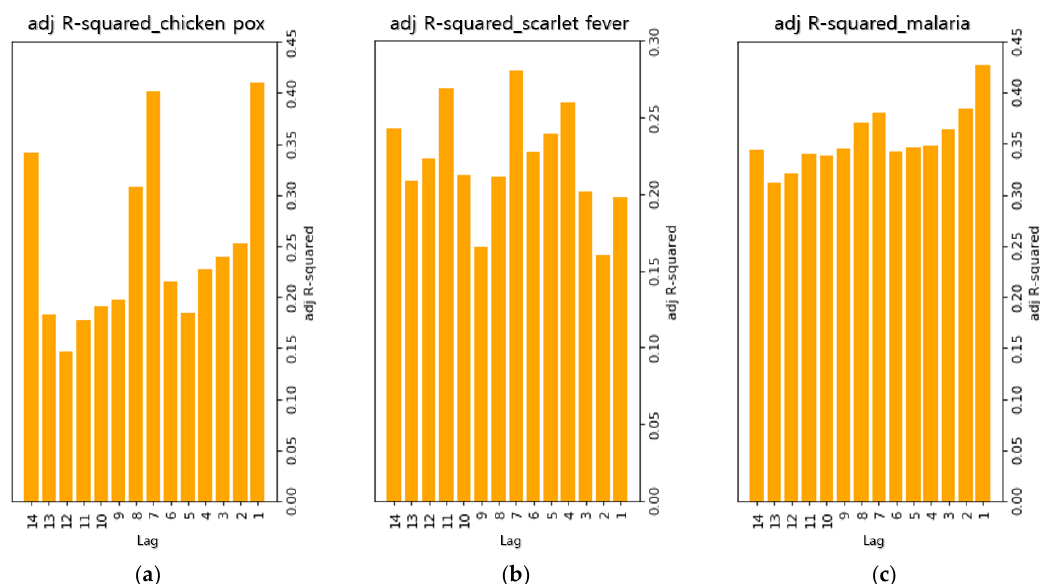
Figure 3. Adjusted R-squared for each lag. ( a ) Adjusted R-squared values of regression models that applied lag of 1 – 14 days in chickenpox, ( b ) Adjusted R-squared values of regression models that applied lag of 1 – 14 days in scarlet fever, ( c ) Adjusted R-squared values of regression models that applied lag of 1 – 14 days in malaria.